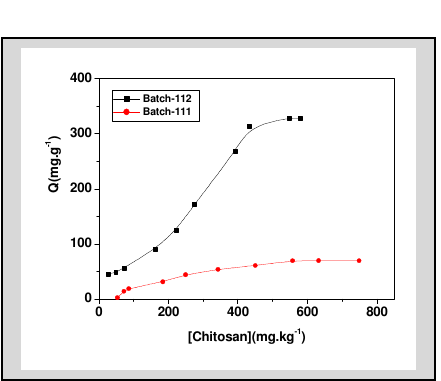
Fig. 6. Isotherm of adsorption of chitosan on the activated carbon in aqueous solution pH = 4 at T = 298